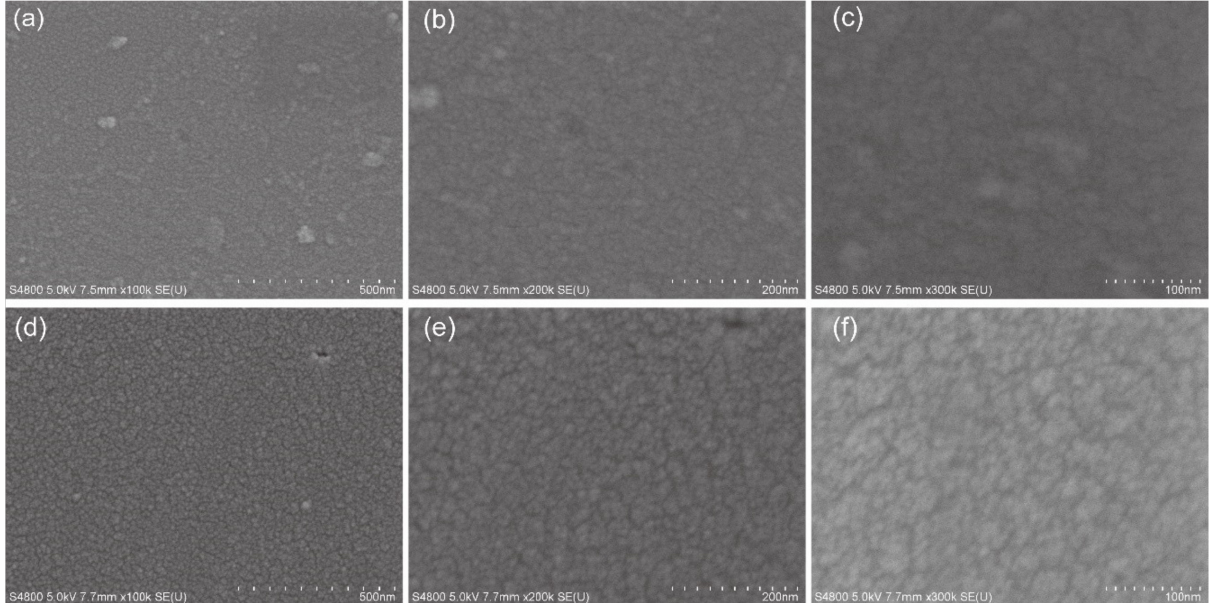
Figure 4. SEM images of PAPEK-virgin membranes ( a – c ) and PAPEK-130 membranes ( d – f ). High cross-mixing of V ions through the membrane in a VFB would lead to an imbal- ance between positive and negative electrolytes, which would lead to a lower Coulomb efficiency and capacity retention. Therefore, membrane selectivity is vital for identifying appropriate membranes for VFBs [54]. The size of ion transport pathways and charged ion exchange groups significantly influences membrane selectivity. In traditional nano- separation structures, the excessive expansion of ion transport pathways increases swelling and thus greatly increases the permeability of V ions due to high membrane swelling